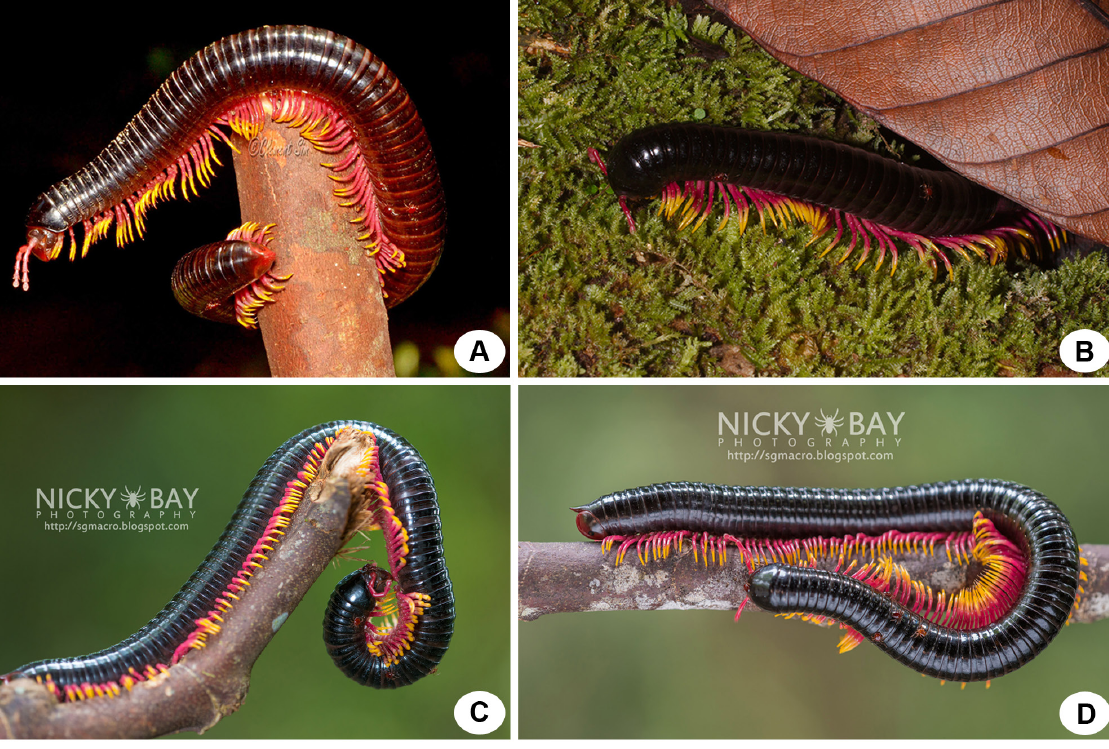
Fig. 7. Specimens from Borneo (Malaysia: Sarawak). A . Living female from Kuching (Photo by Clement Sim). B . Living male from Matang (Photo by Peter Petersen). C – D . Living male from Kubah National Park (Photos by Nicky